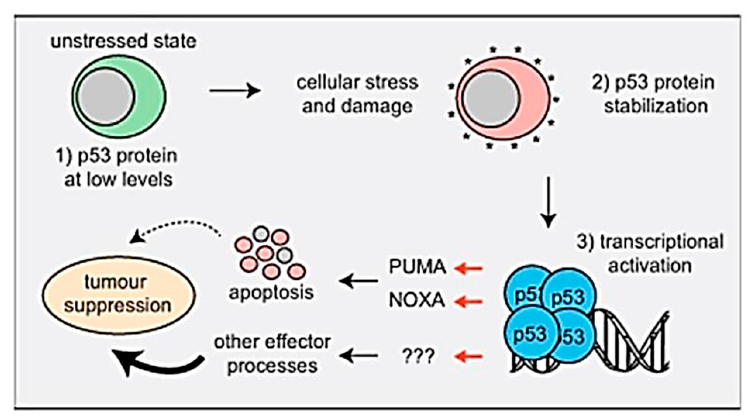
Figure 4. The mechanistic pathway of P 53 -induced cell death and its effect on TP 53 -mediated tumor suppression.